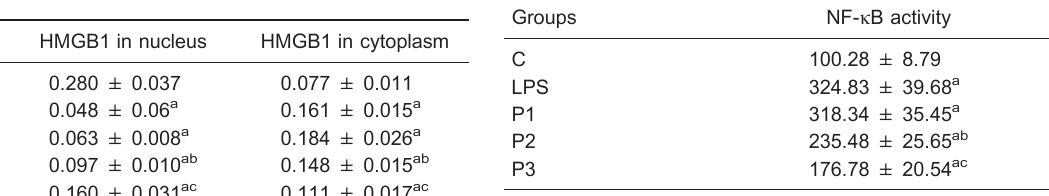
Table 1. HMGB1 protein levels in cell nucleus and cytoplasm in mouse macrophages. Groups